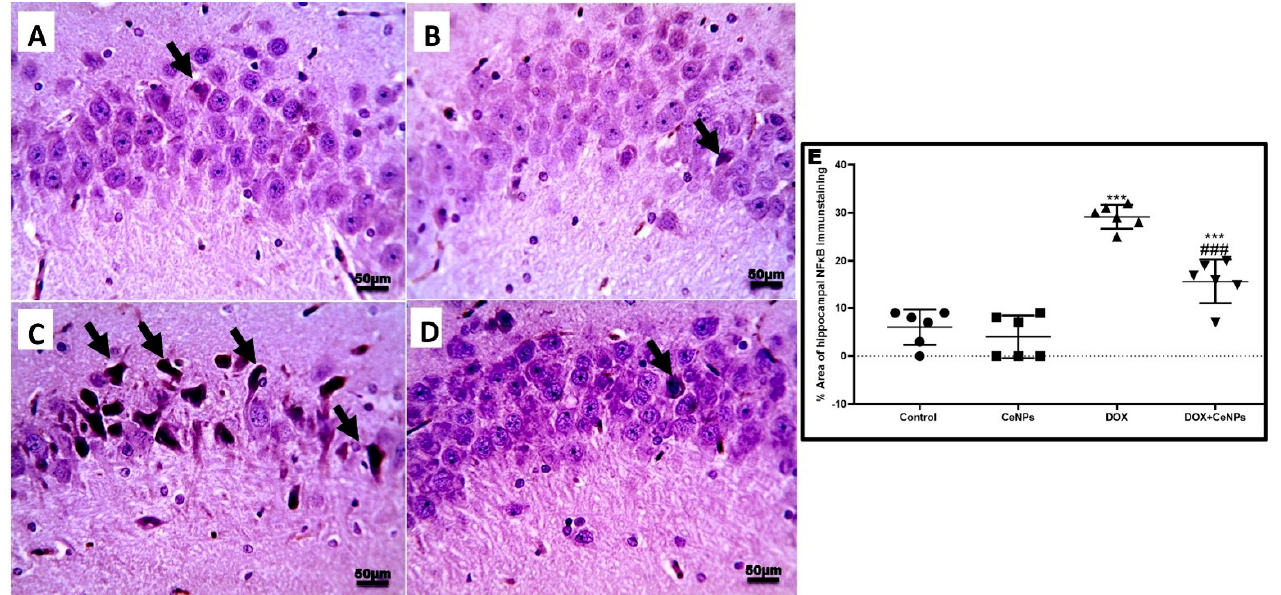
Figure 5. A. Microscopic pictures of immunostained sections of hippocampal sections against NF κ B showing few numbers of positively brown stained neurons in pyramidal layer in (CA3) region in both ( A , B ) control group and the group that received CeNPs. ( C ) Hippocampal sections from DOX group showed markedly increased numbers of positively brown stained neurons (black arrows).